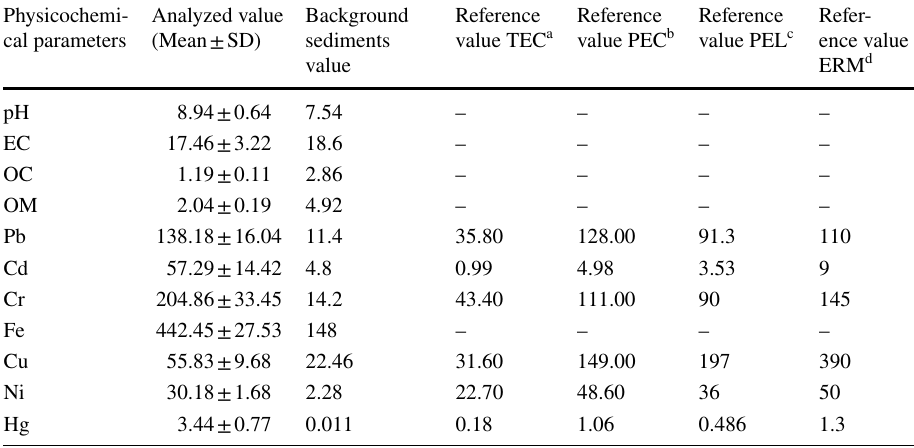
Units: EC in mS/cm, organic C in % and all other parameters in mg/kg